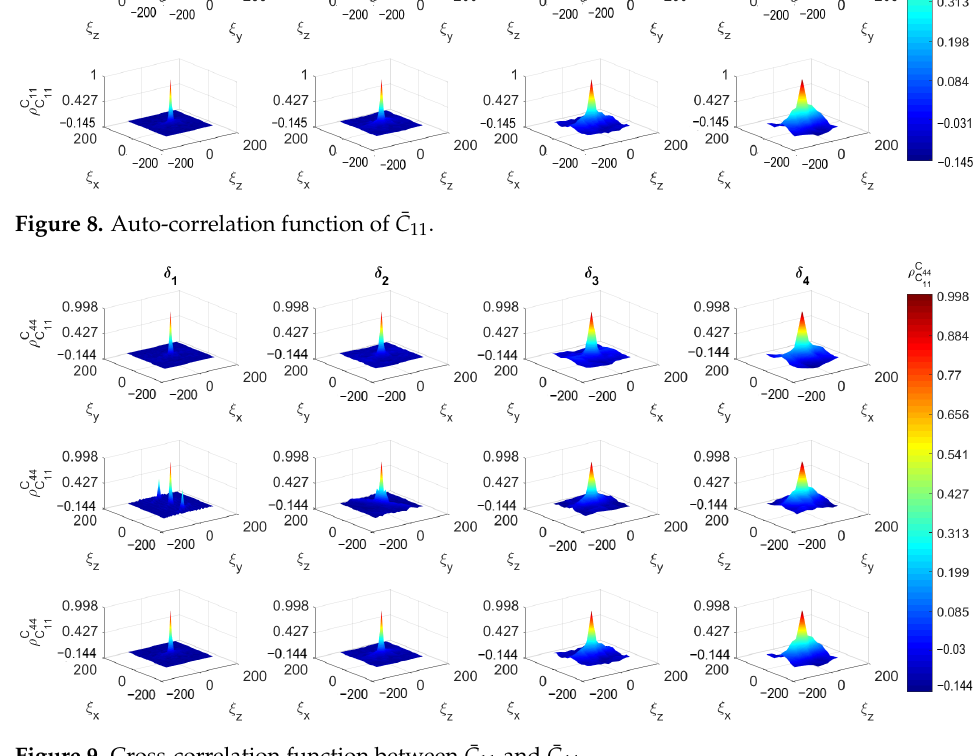
Figure 9. Cross-correlation function between ¯ C 11 and ¯ C 44 .